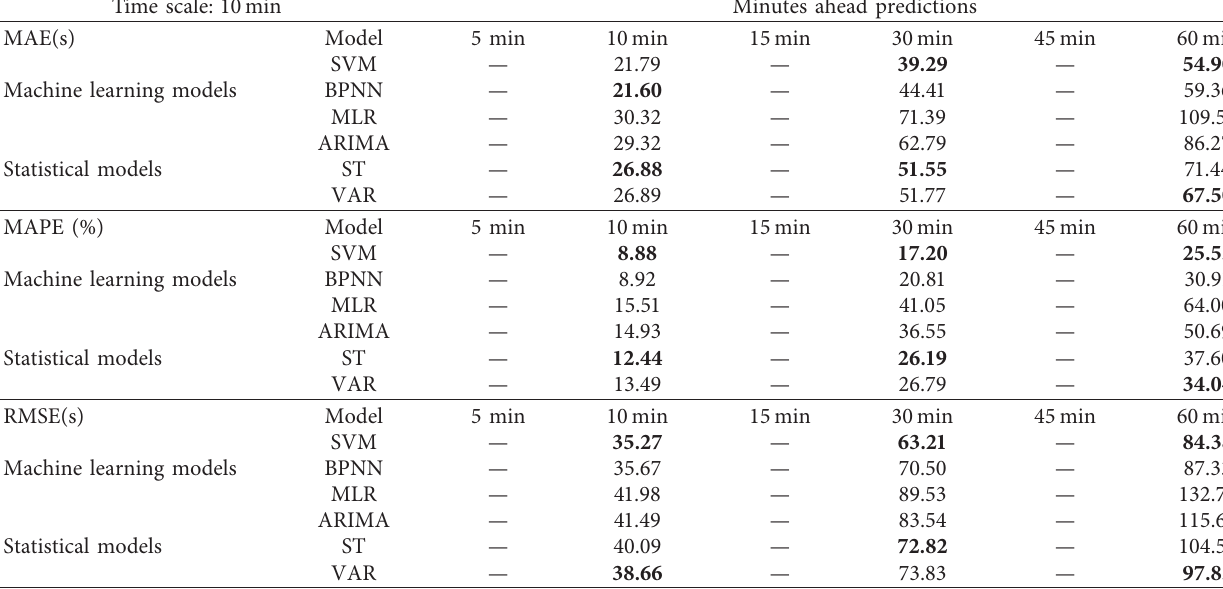
Table 2: MAE, MAPE, and RMSE of six models for different minutes ahead predictions with 10-minute as aggregating level. Time scale: 10min